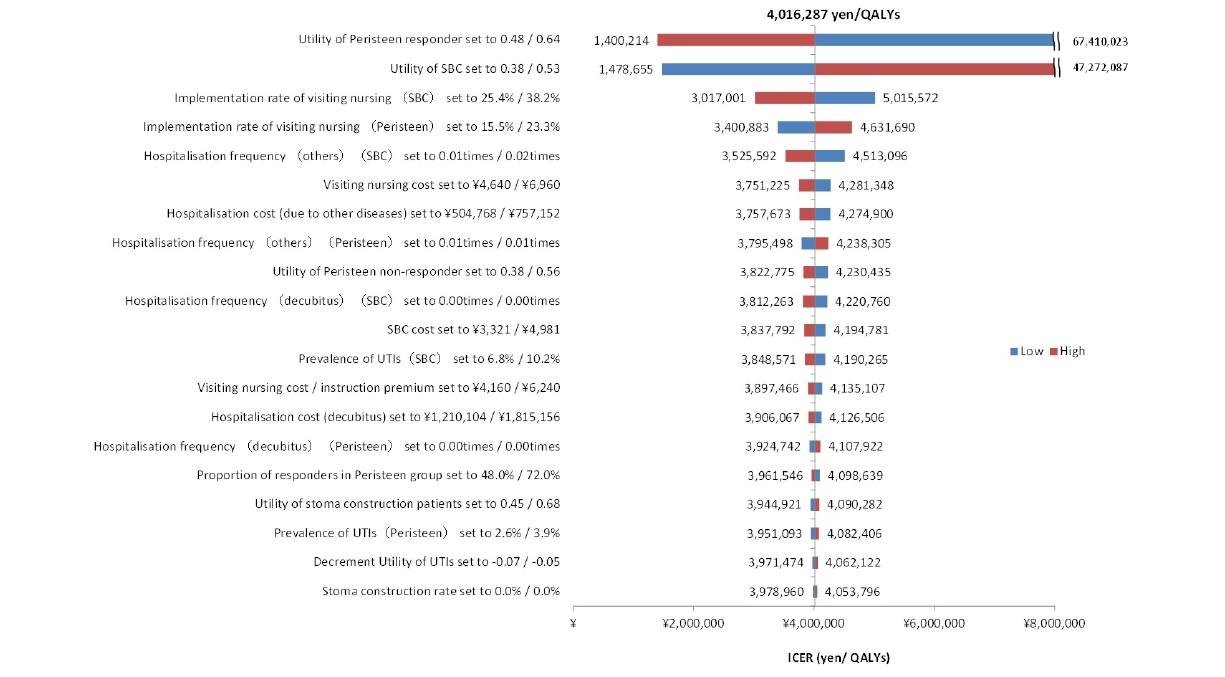
Figure 2. Tornado Diagram